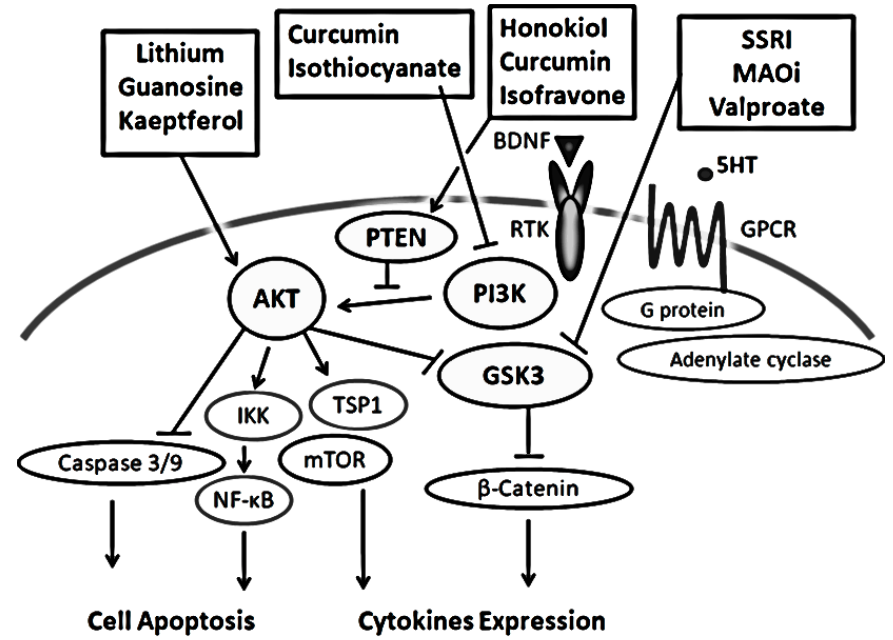
Figure 1. Potential antidepressants and several modulators linked to the predominant molecular targets on PI3K/AKT/GSK3 pathway are demonstrated. Arrowheads mean stimulation whereas hammerheads represent inhibition, suggesting implication of the PI3K/AKT/GSK3 modulators for the treatment of psychiatric illnesses. Note that some critical events have been omitted for clarity. SSRI: Selective Serotonin Reuptake Inhibitors, MAOi: Monoamine oxidase inhibitors, BDNF: Brain-derived neurotrophic factor, 5-HT: 5-hydroxytryptamine,